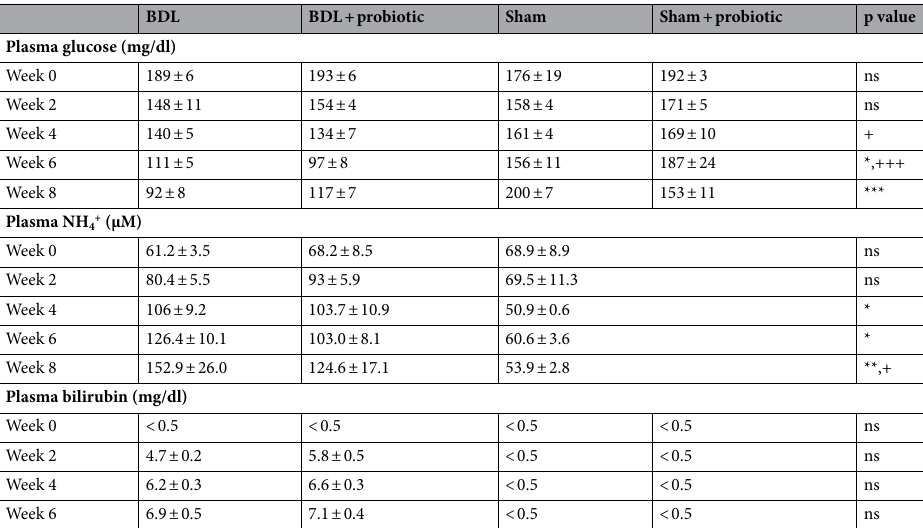
and stayed normal in shams, with no difference between shams and shams + probiotic over the course of the study (Table 2). Plasma NH 4+ at week 6 and 8 was slightly lower in the BDL + probiotic group when compared to the BDL group, although this did not reach statistical significance. Plasma glucose was in the same range before the surgery in all animals and remained in the normal range in both in shams and shams + probiotic throughout the study. In BDL and BDL + probiotic rats plasma glucose levels decreased progressively over the course of the disease (Table 2). Even though BDL and BDL + probiotic had lower body weight than shams and shams + probi- otic, the difference did not reach statistical significance. At week 8, mean body weights were: 299 ± 10 g in BDL group, 336 ± 16 g in BDL + probiotic group, 352 ± 17 g in sham group and 363 ± 13 g in sham + probiotic group.